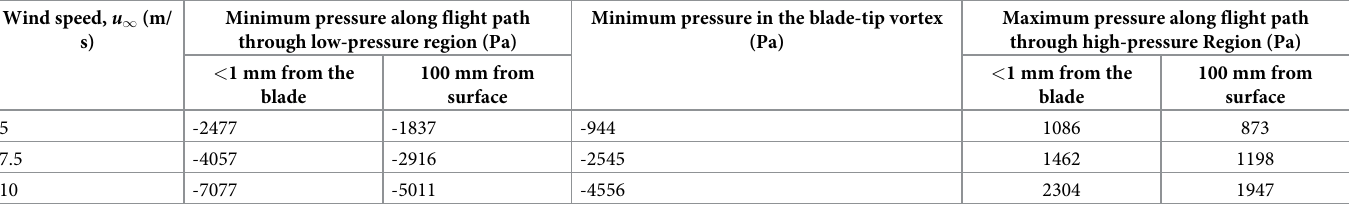
Table 3. The minimum and maximum pressures bats could experience when flying near the 90% blade span location at a flight speed of 10 m/s and near the blade- tip vortex of the NREL 5 MW reference turbine, with respect to atmospheric pressure. Wind speed, u 1 (m/ Minimum pressure along flight path Minimum pressure in the blade-tip vortex s) through low-pressure region (Pa) (Pa)